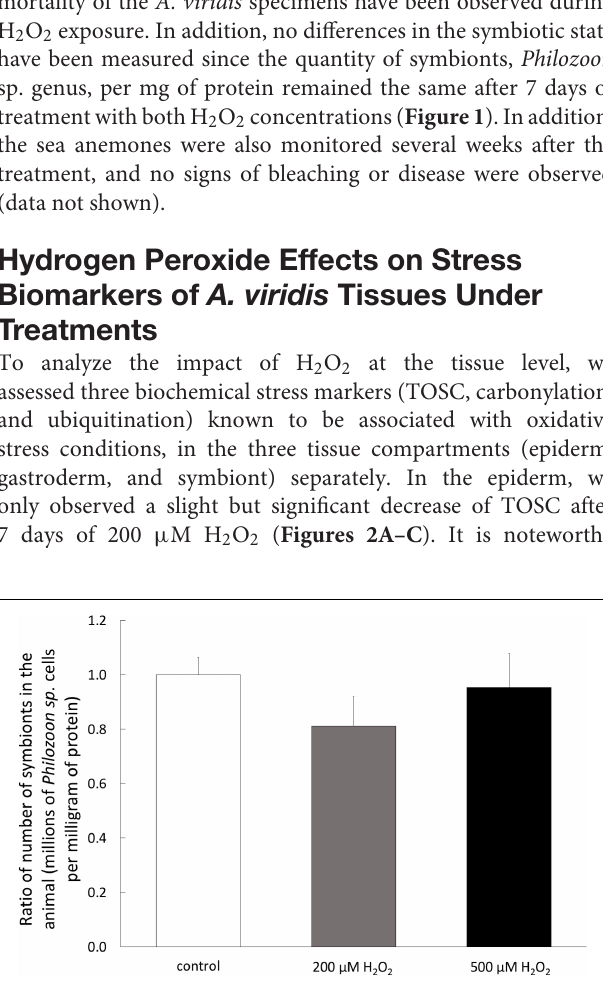
FIGURE 1 | Symbiotic state of A. viridis specimens under H 2 O 2 treatments. Content of Philozoon sp. symbionts in the tentacles of A. viridis before and after 7 days of 0 µ M (control, white bars) 200 µ M (gray bars) and 500 µ M (black bars). At day 0, the A. viridis specimens hosted 2.3 × 10 6 symbiont mg − 1 . Data are represented as means with standard error